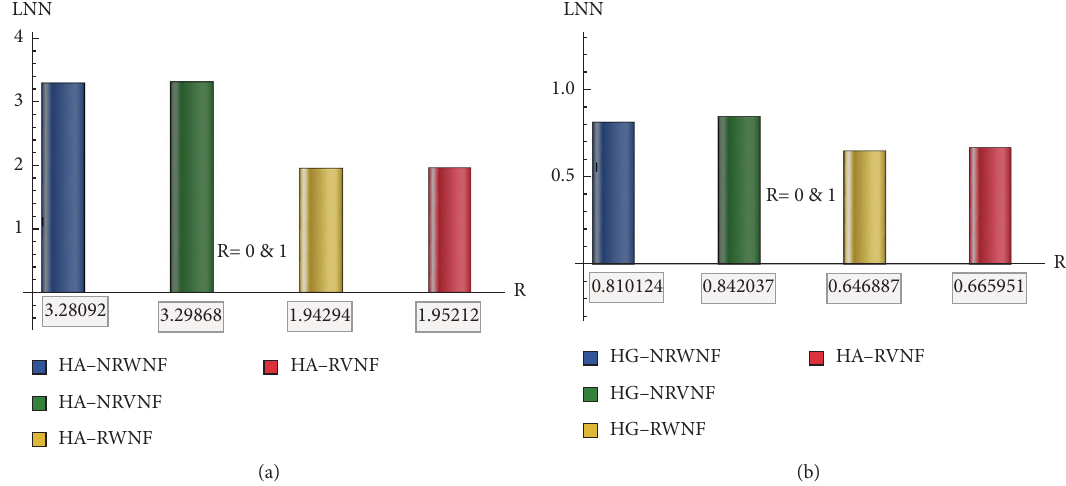
Figure 12: The local Nusselt number on various combinations of Hg and R of a FHF flow of WNF and VNF.